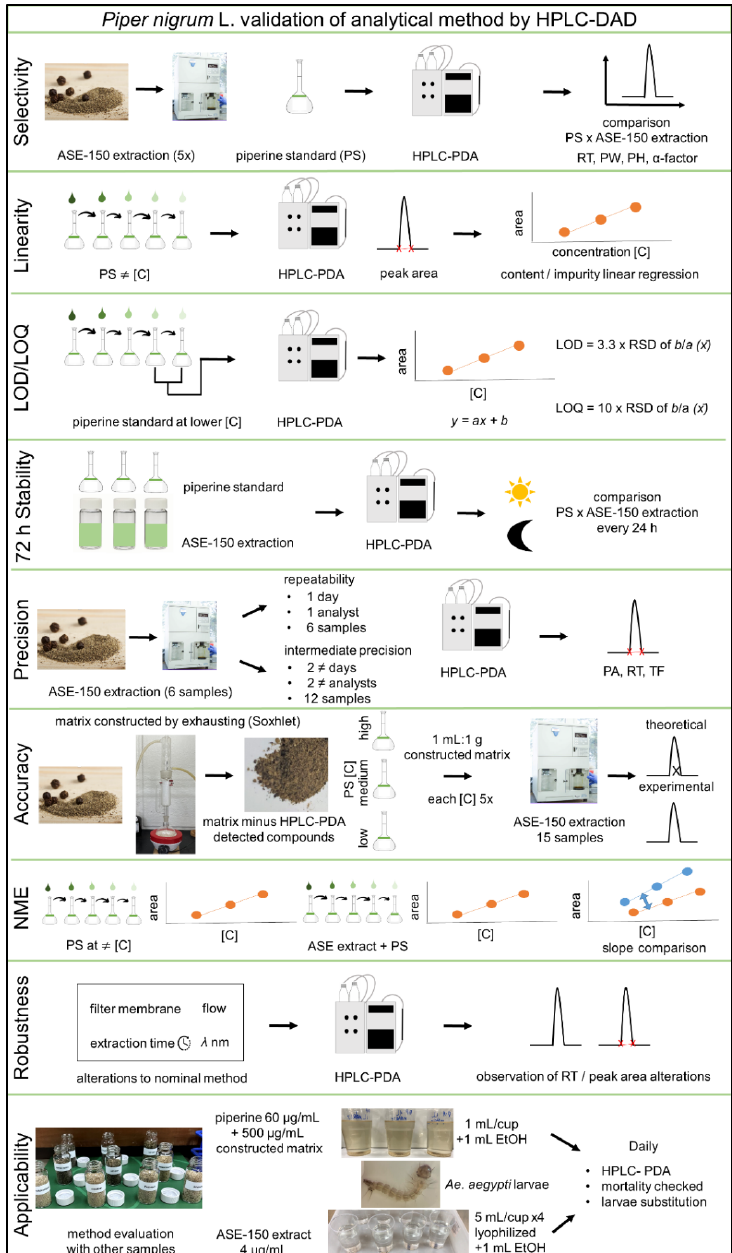
Figure 1. Overview of the steps involved in validating the Piper nigrum fruit (black pepper) ethanolic extract analytical method and its application in Ae. aegypti larvicidal assays.